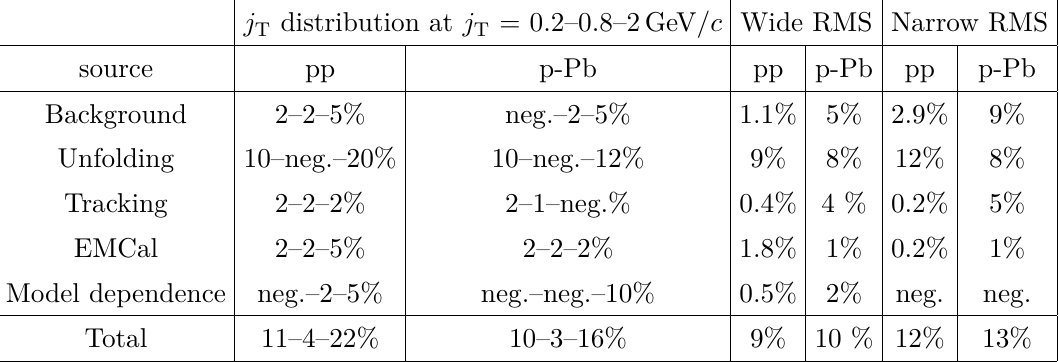
Table 1. Summary of systematic uncertainties for 40 < p T , jet < 60 GeV/ c in pp and p-Pb